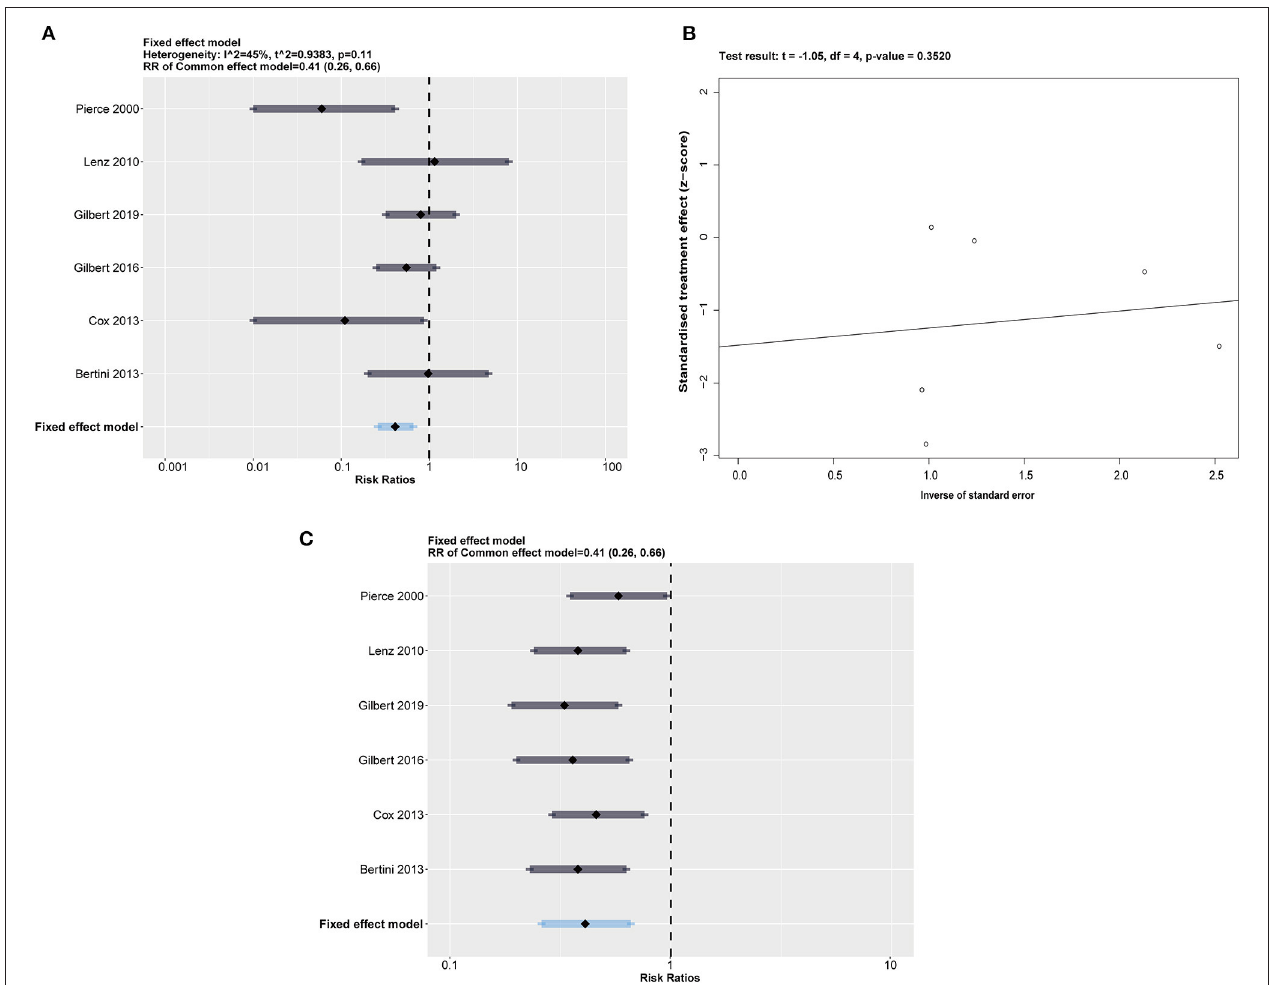
FIGURE 3 | (A) Forest plot of the risk of CRBSI for impregnated catheters. All impregnated medicines were calculated together, with a summary RR = 0.41 (0.26, 0.66) under a fixed effect model. (B) Egger’s test plot shows an acceptable p > 0.3520. (C) The sensitivity analysis performed by eliminating one included study in a time represents a relatively robust